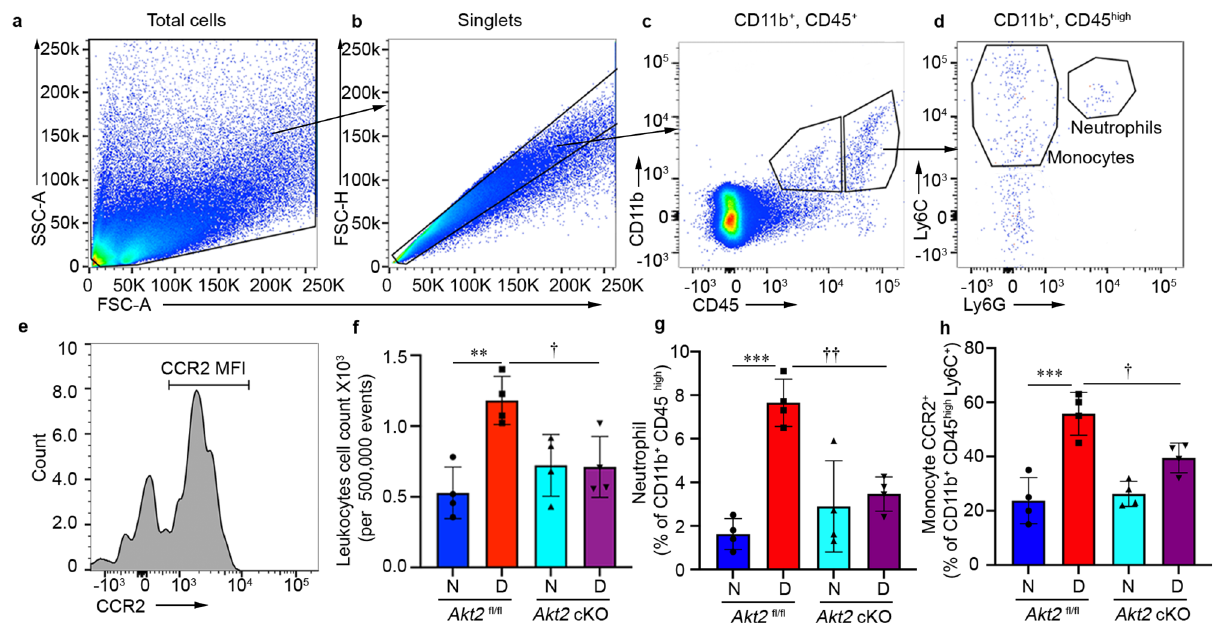
Fig.3|Flowcytometrytoidentifythepopulationofleukocytesin fi ltratingthe RPE and retina isolated fromdiabetic(2 monthsofdiabetes)and age-matched nondiabetic Akt2 fl / fl and Akt2 cKO mice. a FSC-A versus SSC-A dot plots were gated to eliminate debris. b Single cells were selected on FSC-A versus FSC-H. c RepresentativedotplotsweregatedonCD11b + andCD45 + cells. d Ly6C,Ly6Gand ( e ) CCR2 antibodies were used to de fi ne the neutrophils and monocytes gated on CD11b + CD45 high cells. f The absolute number of in fi ltrating leukocytes (CD11b + CD45 high )wasincreasedin Akt2 fl / fl diabeticmice.However,thiswasinhibitedinRPE- speci fi c Akt2 cKO diabetic mice. g The neutrophil and ( h ) monocyte populations were increased in the retinas of Akt2 fl / fl diabetic mice compared to nondiabetic